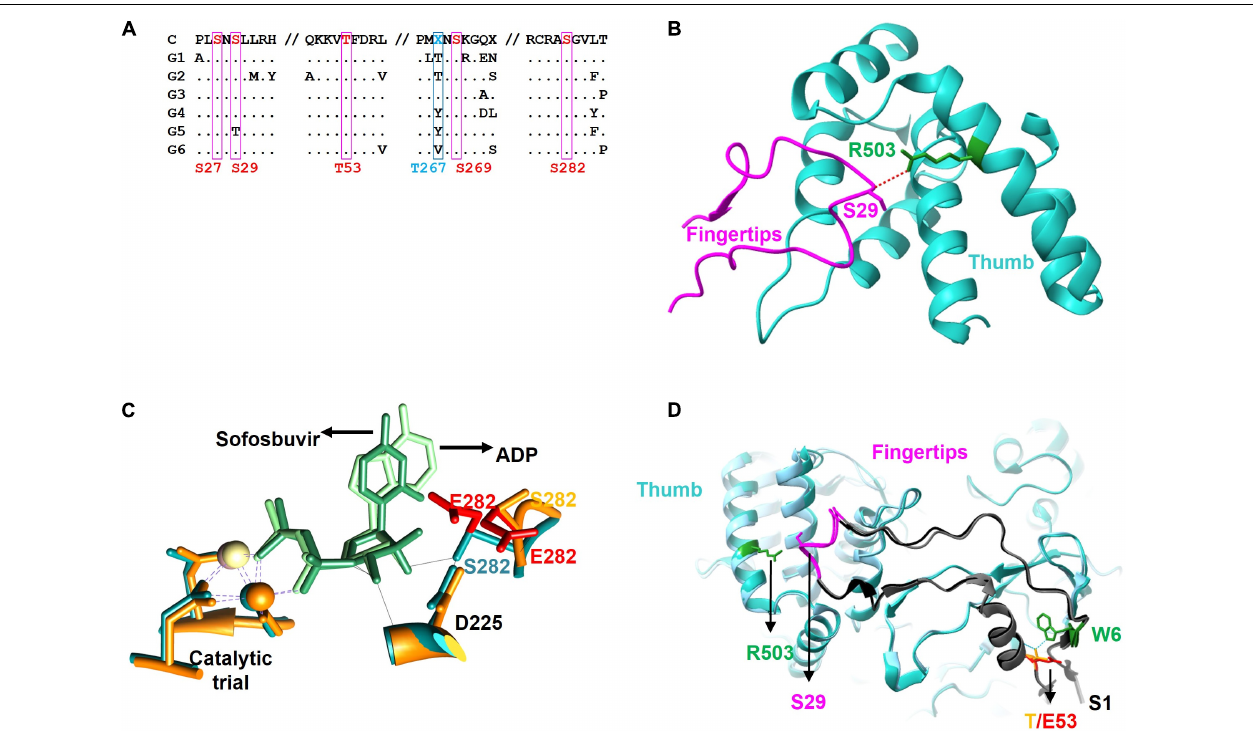
FIGURE 8 | Sequence and structure of the NS5B protein. (A) Partial amino acid sequence alignment of the consensus sequences of the major HCV genotypes (G1, G2, G3, G4, G5, and G6) showing the positions described in this work (S27, S29, T53, S269, and S282 in red and T267 in blue) as well as the surrounding residues. The consensus sequence is shown at the top (C) . Conserved residues are represented as a dot. (B) Zoom of the fingertip region of the NS5B protein showing residues S29 (magenta, fingertip domain) and R503 (blue, thumb domain) and the hydrogen bond connecting them (red dashed line). (C) Zoom of the catalytic center of NS5B obtained by aligning the protein structures in the presence of ADP (blue backbone) and sofosbuvir (orange backbone). The catalytic triad coordinated with beta and gamma phosphates of the incoming nucleotide (ADP in light green and sofosbuvir in dark green), and positions D225 and S282 are shown. The most likely rotamers for the S282E mutant are shown in red. (D) Zoom showing the (cid:49) 1 loop in dark gray. Fingertips with the amino acid S29 and its partner R503 are shown on the left side of the image. On the right are residues S1 (gray), W6 (green) and T53 (orange), as well as the most likely rotamer for the T53E mutant (in red). Hydrogen-bridging bonds between T53 and W6 are shown with dotted blue lines.